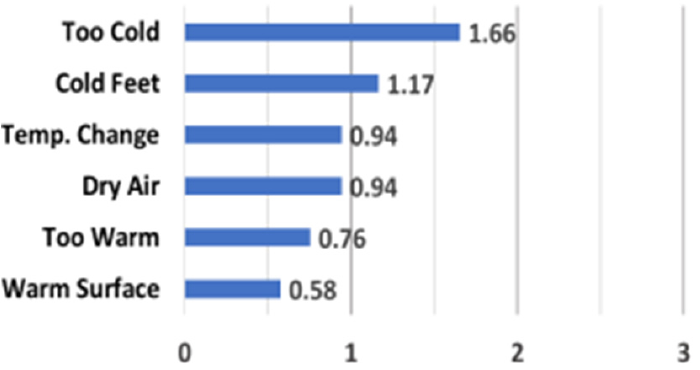
Figure 8. Frequency scores of sources contributing to discomfort and dissatisfaction toward thermal comfort.